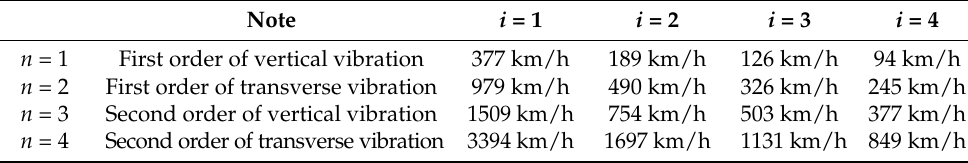
Table 5. Theoretical resonant velocity of each order of a bridge with a span of 25